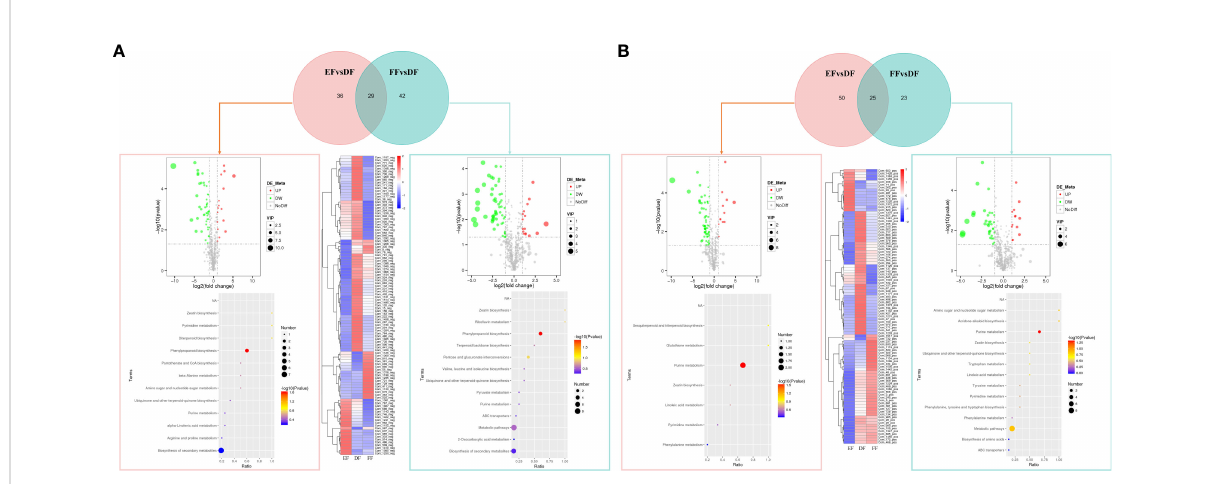
FIGURE 5 Overview of metabolic pro fi les in strawberries at different temperature in negative (A) and positive (B) ion modes. Venn diagram of the number of downregulated and upregulated components in different comparison group. Volcano map for the signi fi cance level of the DEGs. The horizontal axis represents the fold change of DEGs, and the vertical axis represents the signi fi cance level of the difference. Padj indicates the corrected p value after the multiple hypothesis test, Cluster heat map of metabolic pro fi les of different samples. The normalized metabolites content data after taking the logarithm was prepared for making the heatmap. KEGG enrichment pathways of differential metabolites in different comparison groups. The size of the dot represents the number of differential metabolites enriched in different pathways, and their color represents the signi fi cance level of the difference. Ratio represents the ratio of the number of differential metabolites annotated to the KEGG pathway to the total number of differential